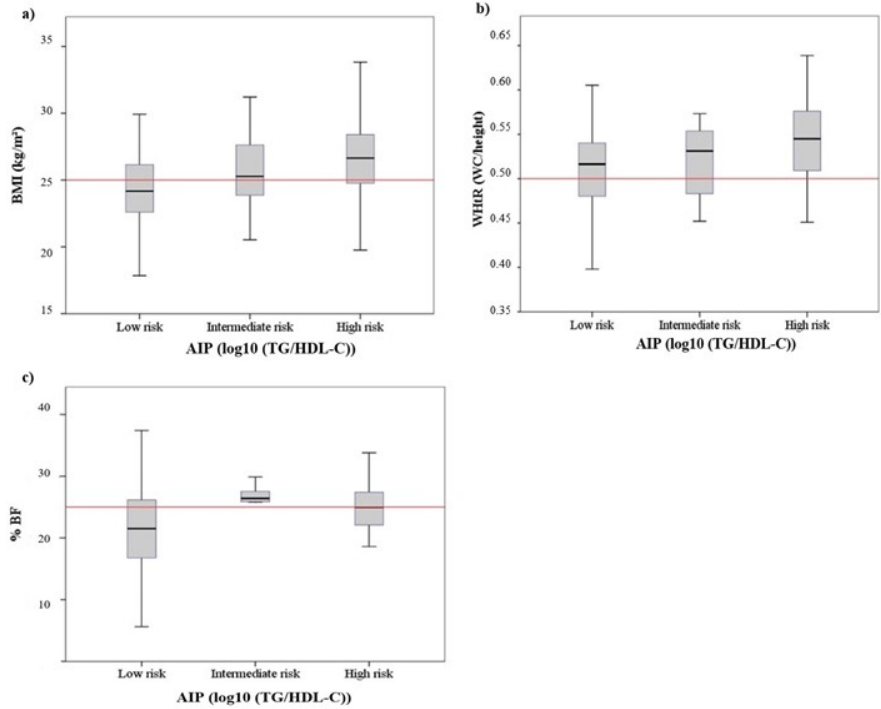
Figure 1. Anthropometric parameters boxplots: ( a ) BMI, ( b ) WHtR and ( c ) %BF, according to the different levels of AIP.